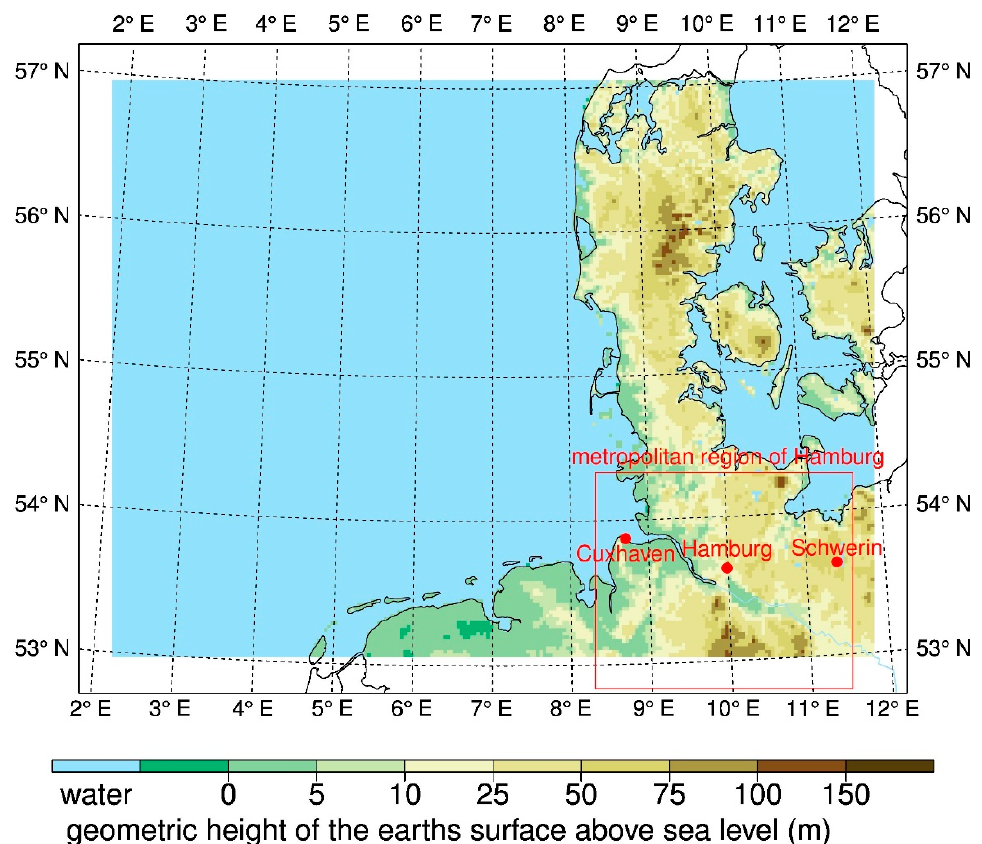
Figure 1. Model domain of the 2.8 km simulation GB0028 with sponge zone, location of the cities Cuxhaven, Hamburg, and Schwerin, and the metropolitan region of Hamburg.